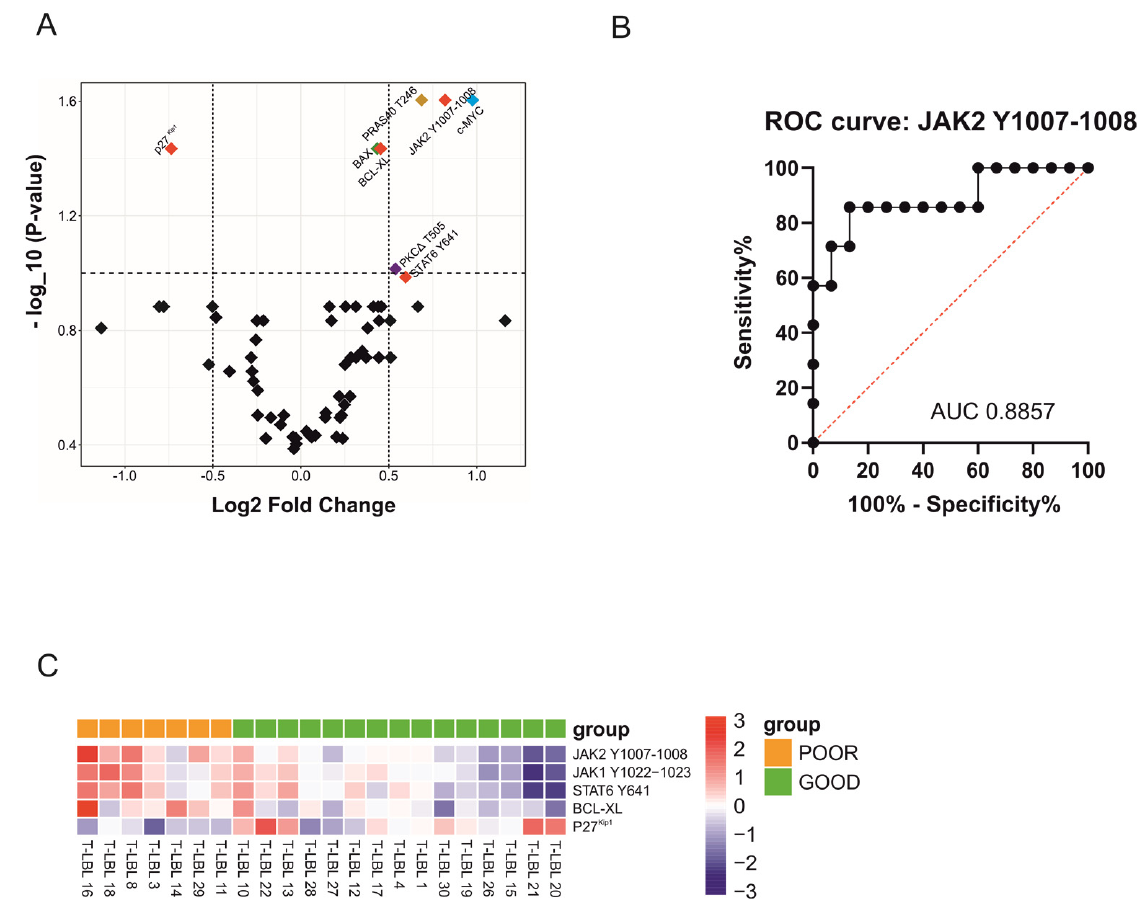
Figure 1. JAK1/2-STAT6 pathway in T-LBL pediatric patients. ( A ) Volcano plot of all proteins evaluated by RPPA. Log2 Fold Change, given for each protein, is computed as the difference in the means of log base 2 between good vs. poor prognosis. A Log2 Fold Change equal to 0 indicates no difference, higher than 0 indicates that the mean in patients with good prognosis is higher than the mean for poor prognosis. Statistical significance for each protein is reported in the vertical axes (as -log base 10 of the q-values). Q-values ≤ 0.1 are equivalent to points above (or on) the horizontal dashed line. In red, proteins belonging to the JAK1/2-STAT6 pathway (JAK2 Y1007-1008, STAT6, BCL-XL, p27 kip1 ), in orange PRAS40 T246, in blue c-MYC, in green BAX and in violet PKC Δ T505. ( B ) Receiver operating characteristic (ROC) analysis of the signal intensities obtained by RPPA raw data for JAK2 Y1007-1008 expression in T-LBL patients. ( C ) Heatmap showing the activation status of the proteins belonging to the JAK1/2-STAT6 signaling pathway in good vs. poor prognosis T-LBL patients. RPPA raw data were log2 transformed and each intensity value was plotted and scaled by row.